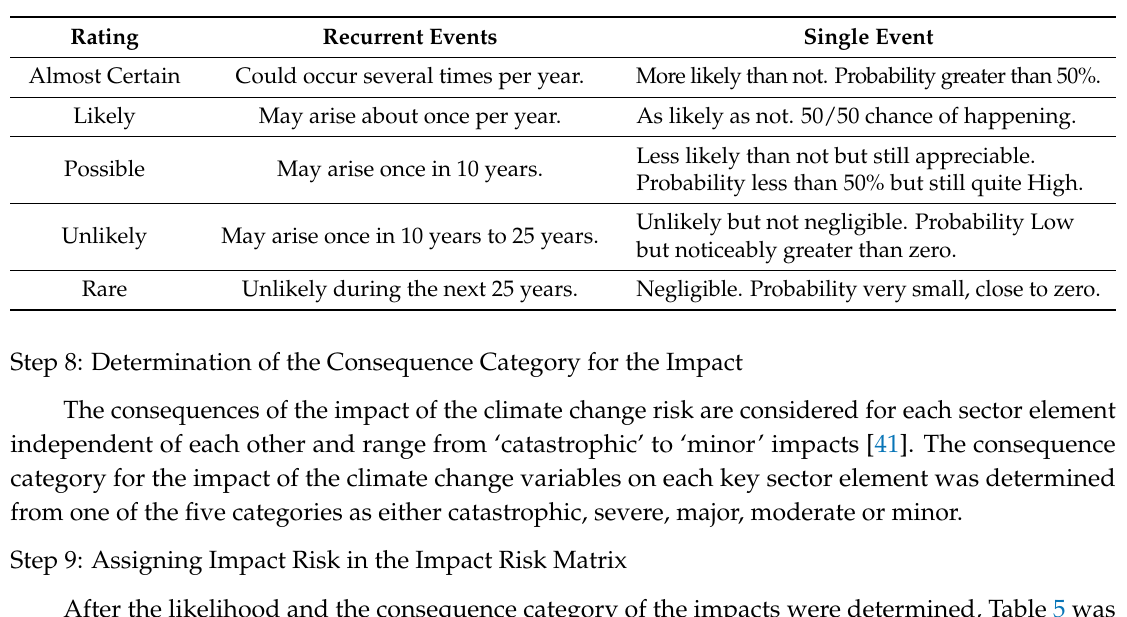
Table 4. Likelihood Categories Describing the Occurrence of Each climate change Impact.